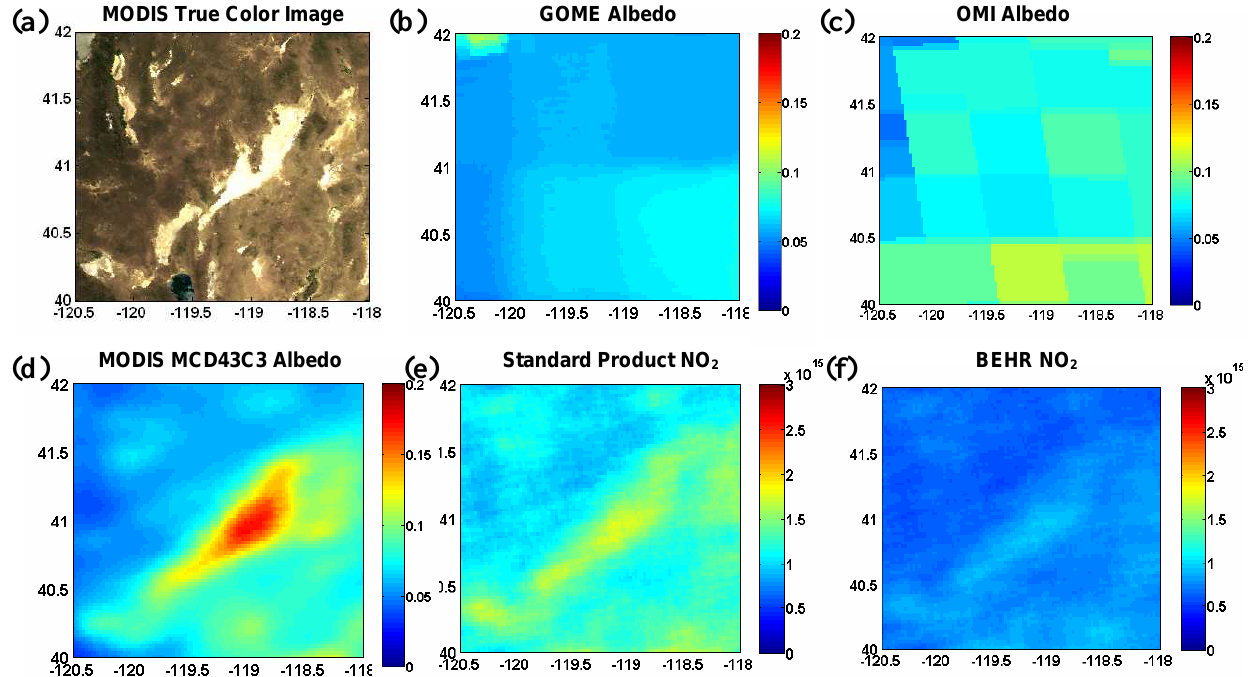
Fig. 2. (a) MODIS true color image of a salt flat in north western Nevada on 18 June 2008. Albedo used in (b) the operational retrievals for October 2004–February 2009 (GOME climatology, monthly at 1 ◦ × 1 ◦ ), (c) the operational retrievals for February 2009 – today (OMI climatology, monthly at 0 . 5 ◦ × 0 . 5 ◦ ), and (d) the BEHR retrieval (MODIS MCD43C3, 16 day average every 8 days, at 0 . 05 ◦ × 0 . 05 ◦ ) for 18 June 2008. Average OMI tropospheric NO 2 column from (e) the Standard Product and (f) the BEHR retrieval for June-August